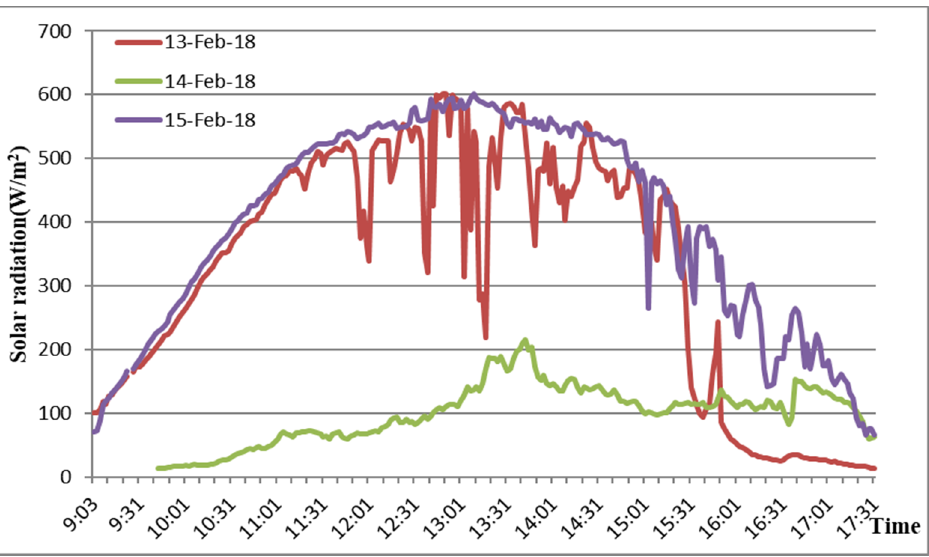
Figure 5. G. Figure 5. G.